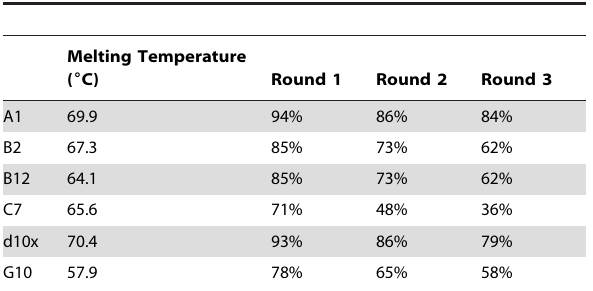
Table 1. Melting temperatures and recovery of native structure.